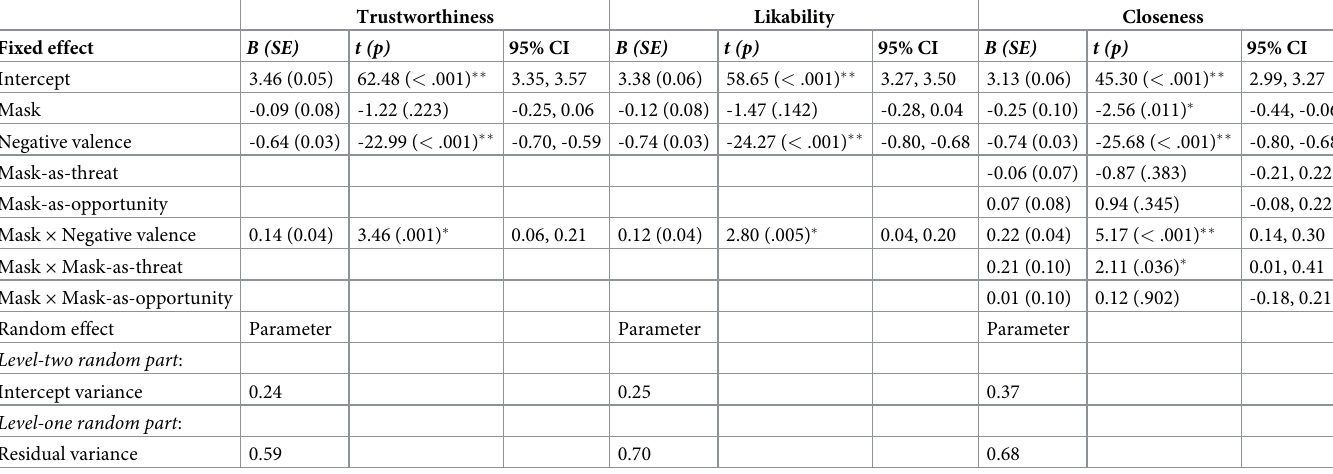
Table 3. Multilevel regression models capturing the effect of condition, valence, and mask-related associations on social judgments. Trustworthiness